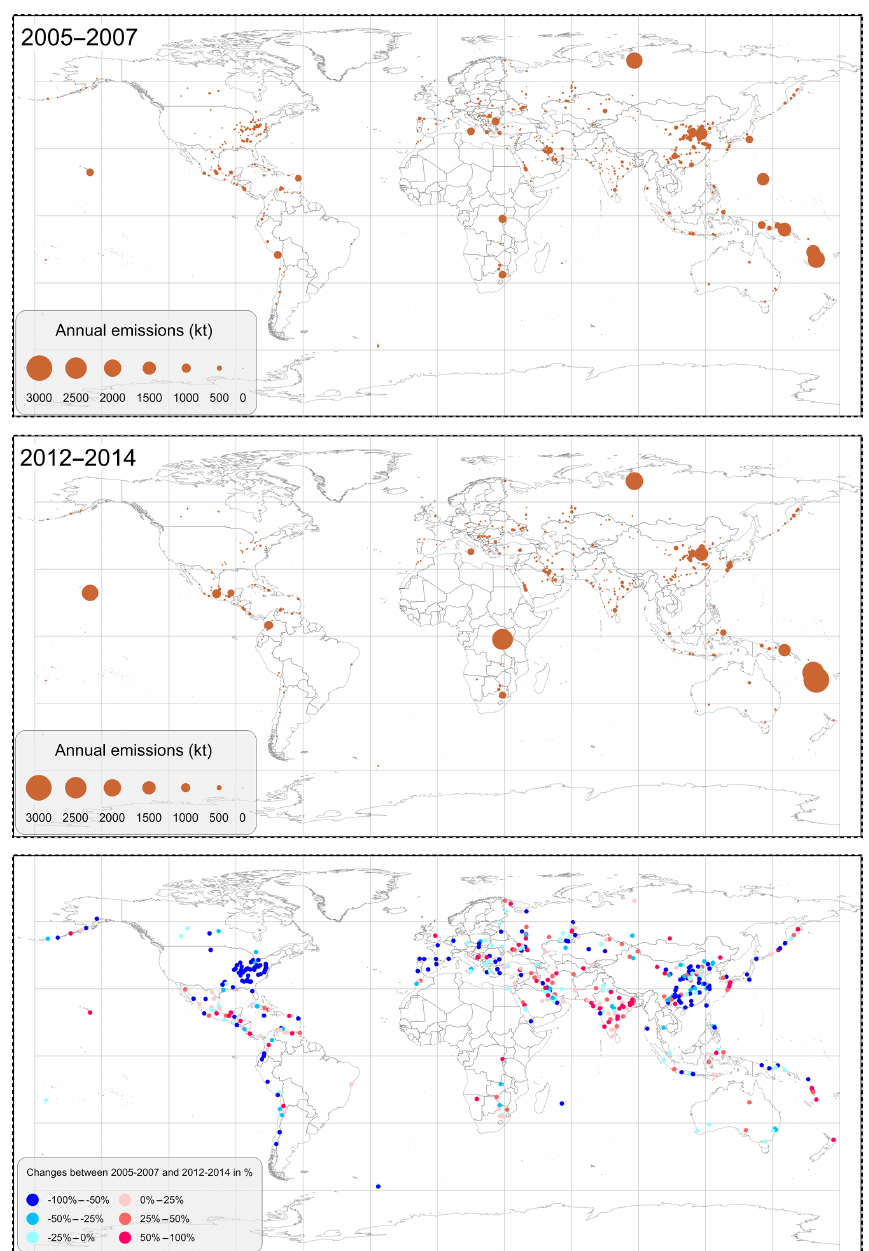
Figure 11. Top: strength of SO 2 emission sources in (top) 2005–2007 and (middle) 2012–2014. The size of the symbols is proportional to the mean annual emission values. Bottom: relative changes between 2005–2007 and 2012–2014 emission values as percentage of the mean 2005–2014 annual emissions. Only sources with mean 2005–2014 emissions greater than 30kt are shown. Note that some dots in China represent area